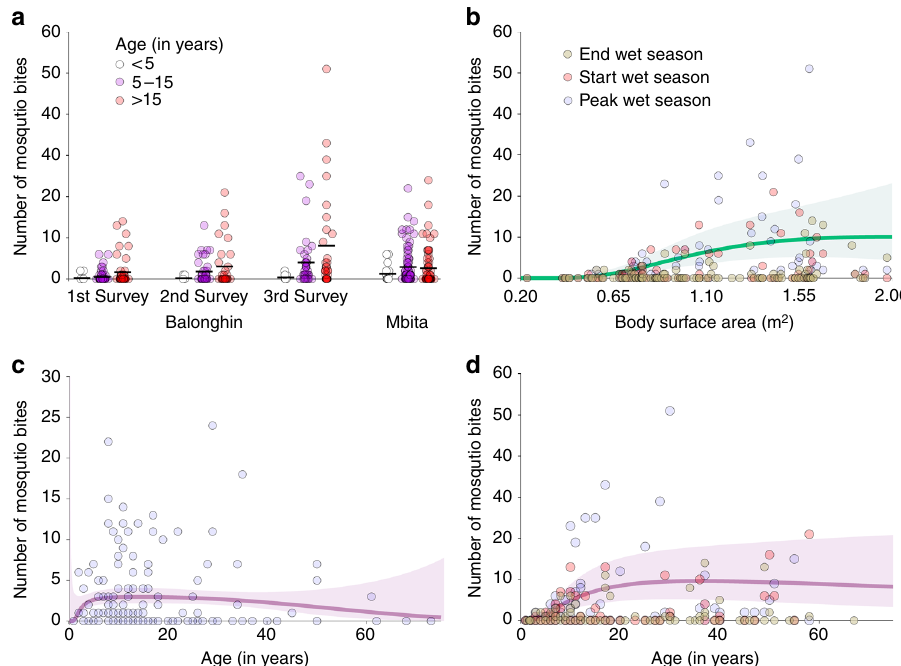
Fig. 2 Mosquito exposure by age and body surface area. In a , the number of mosquito bites for each age group and survey is presented; each circle represents a study participant, and the mean number of mosquito bites per individual by age group is represented by horizontal black lines. In b – d , fractional polynomials were used to determine the models that best describe the relationships between mosquito bites and age in Mbita ( c ) and Balonghin ( d ) and mosquito bites and body surface area calculated using Dubois equation ( b , data from Balonghin). The lines in b – d represent predicted numbers of mosquito bites per individual based on selected models (see ‘ Methods ’ section). The green ( b ) and purple ( c , d ) areas represent 95% con fi dence